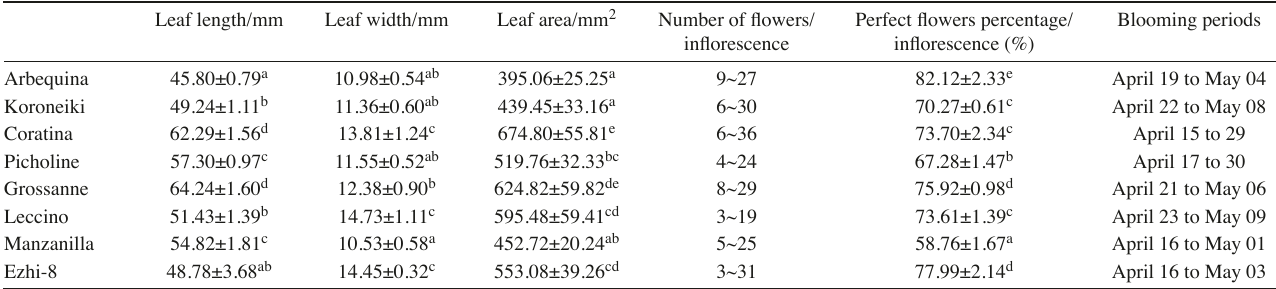
Tab. 1: Leaf and inflorescence characteristics of eight cultivars Leaf length/mm